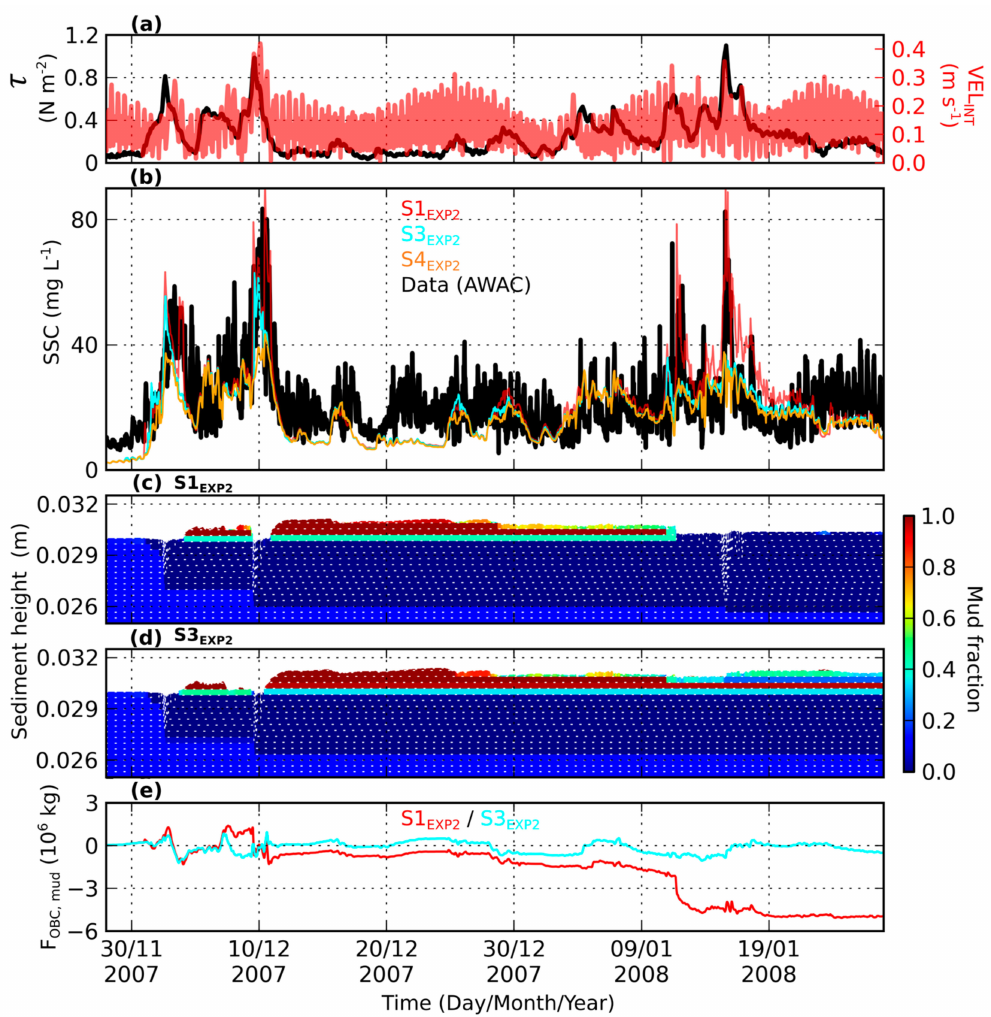
Figure 8. Comparisons of the results of the 3D model obtained from erosion settings S1 EXP 2 , S3 EXP 2 and S4 EXP 2 , and measurements made with the AWAC acoustic profiler. ( a ) Shear stresses τ and depth-integrated currents VEL INT ; ( b ) time series of measured and modelled SSC at the level of the first AWAC cell (1.67 m above the bottom); ( c , d ) changes in the seabed (mud fraction, thickness of the sediment layers) in S1 EXP 2 and S3 EXP 2 simulations (the white dotted lines represent the boundaries of the sediment layers); and ( e ) integrated amount of mud advected through the water column in the S1 EXP 2 and S3 EXP 2